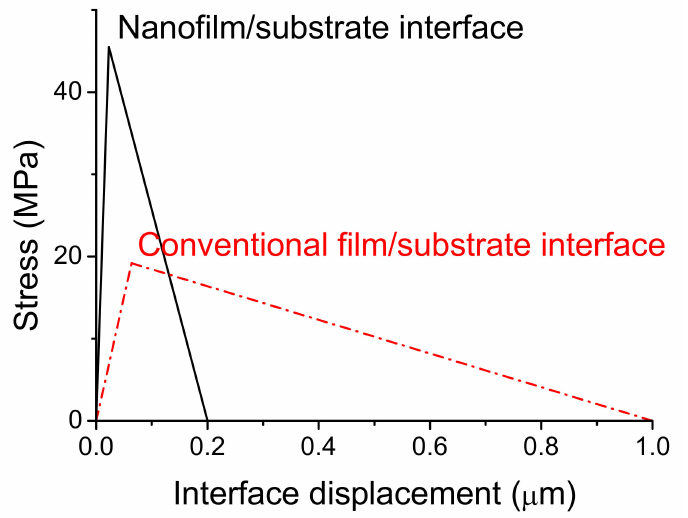
Figure 3. Interface stress-displacement relations of nanocrystalline ceramic film/substrate (black solid curve) and conventional thin film/substrate (red).